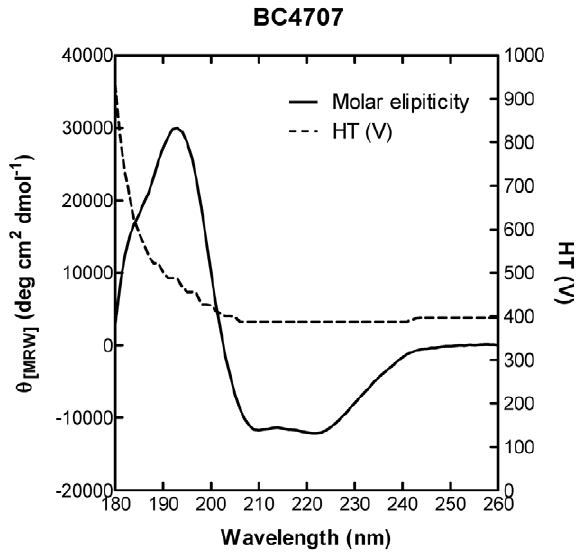
Table 4. Susceptibilities of E. coli DH5 a D acrAB